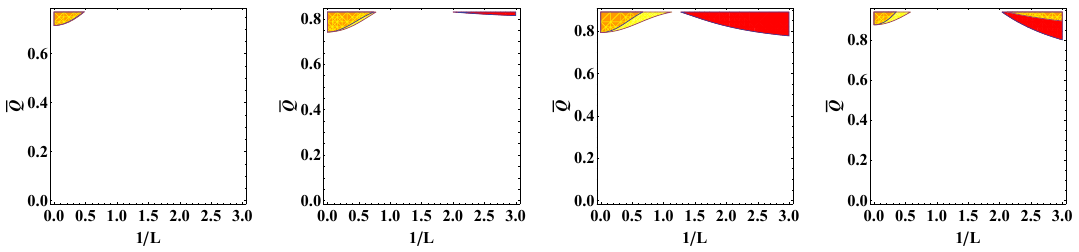
Figure 10 . The unstable regions of the AdS charged Gauss-Bonnet black hole. From the left to the right (cid:11) = (cid:0) 0 : 4 ; (cid:0) 0 : 3 ; (cid:0) 0 : 2 and (cid:0) 0 : 1, respectively, where the red region corresponds to f 1 < 0, the yellow region correspond to f 2 < 0 and the orange region is the overlap which belongs to the stable region. Here we take ‘ = 2.